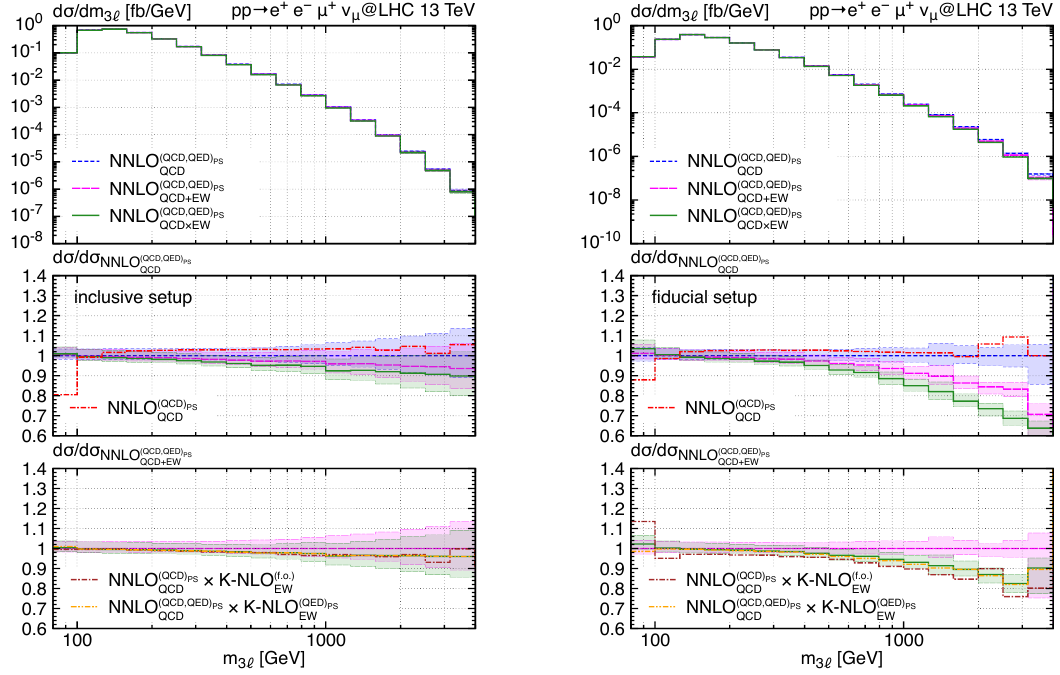
Figure 7. Differential distributions in the invariant mass of the three final-state leptons in W + Z production in the inclusive setup (left) and fiducial setup (right). See text for